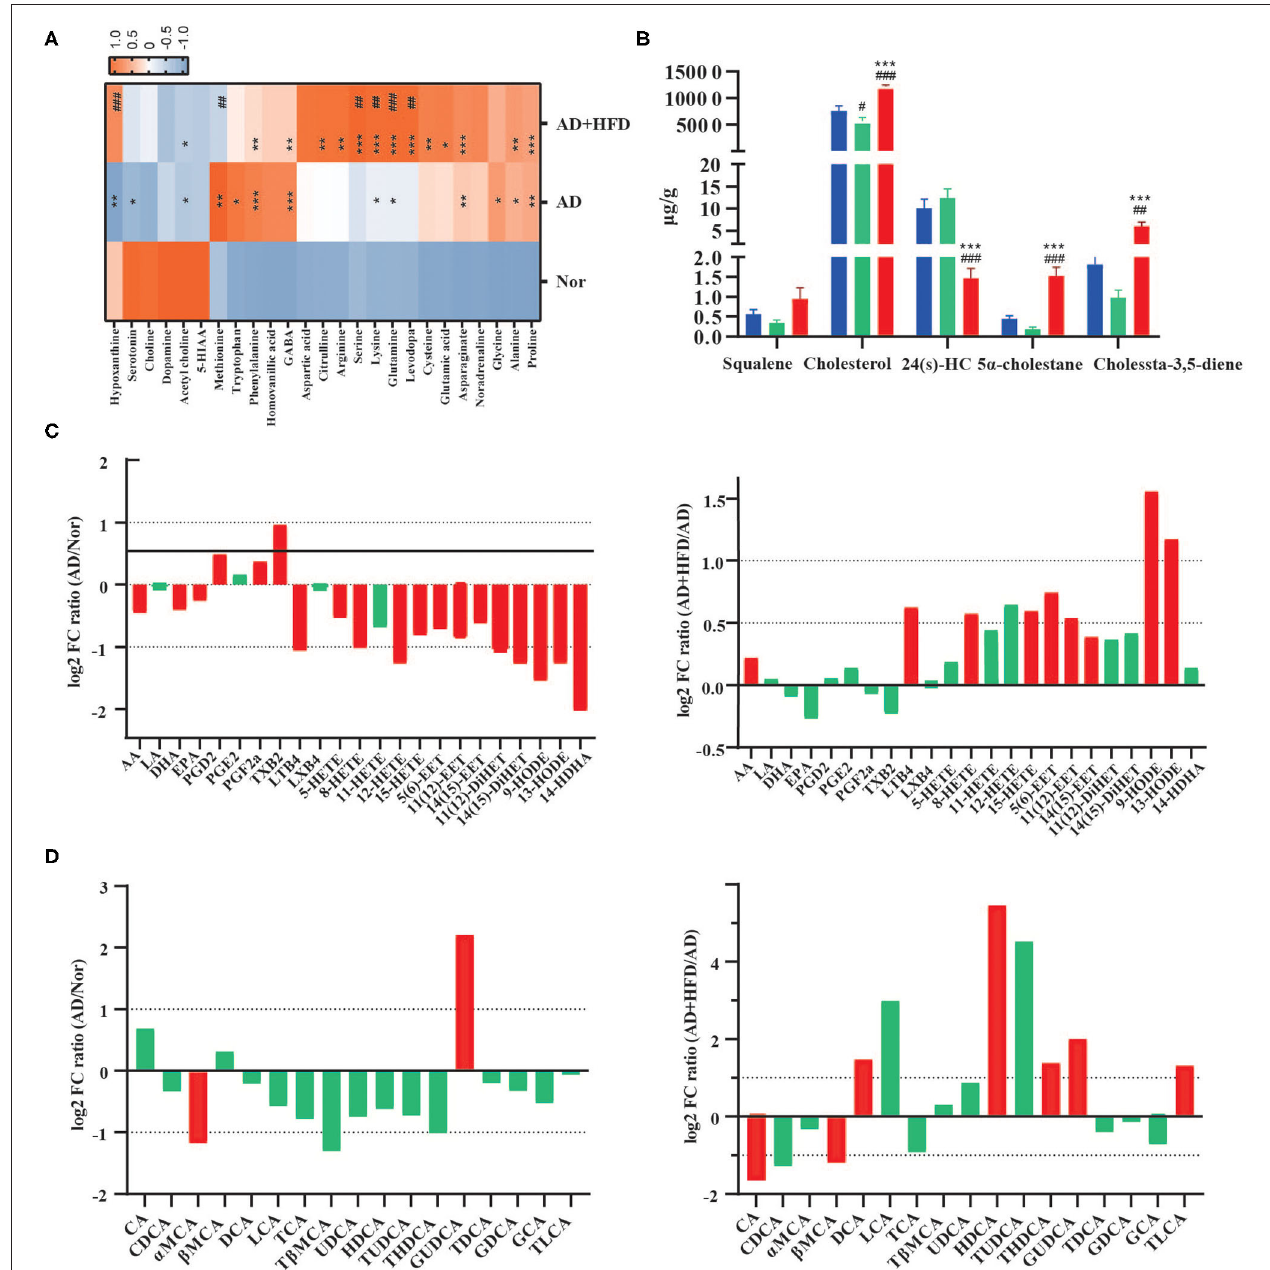
FIGURE 3 | High fat diet altered the metabolite in AD mice. (A) The neurotransmitters and amino acids metabolism in brain tissue. * p < 0.05,** p < 0.01,*** p < 0.001 (compared to Nor group); # p < 0.05, ## p < 0.01, ### p < 0.001 (compared to AD group). (B) The level of cholesterol and its related compounds in brain tissue. # p < 0.05, ## p < 0.01, ### p < 0.001 (compared to Nor group); * p < 0.05,** p < 0.01,*** p < 0.001 (compared to AD group). (C) High fat diet-dependent changes in modulated polyunsaturated fatty acids and peroxilipidos metabolism in brain tissue samples (Log 2 FC). (D) The concentration of 17 bile acids are dynamically changed in the serum (Log 2 FC). The column in red had significant difference and the column in green had no significant difference. Data are presented as mean ± standard error of mean. # compared to Nor group; *compared to AD